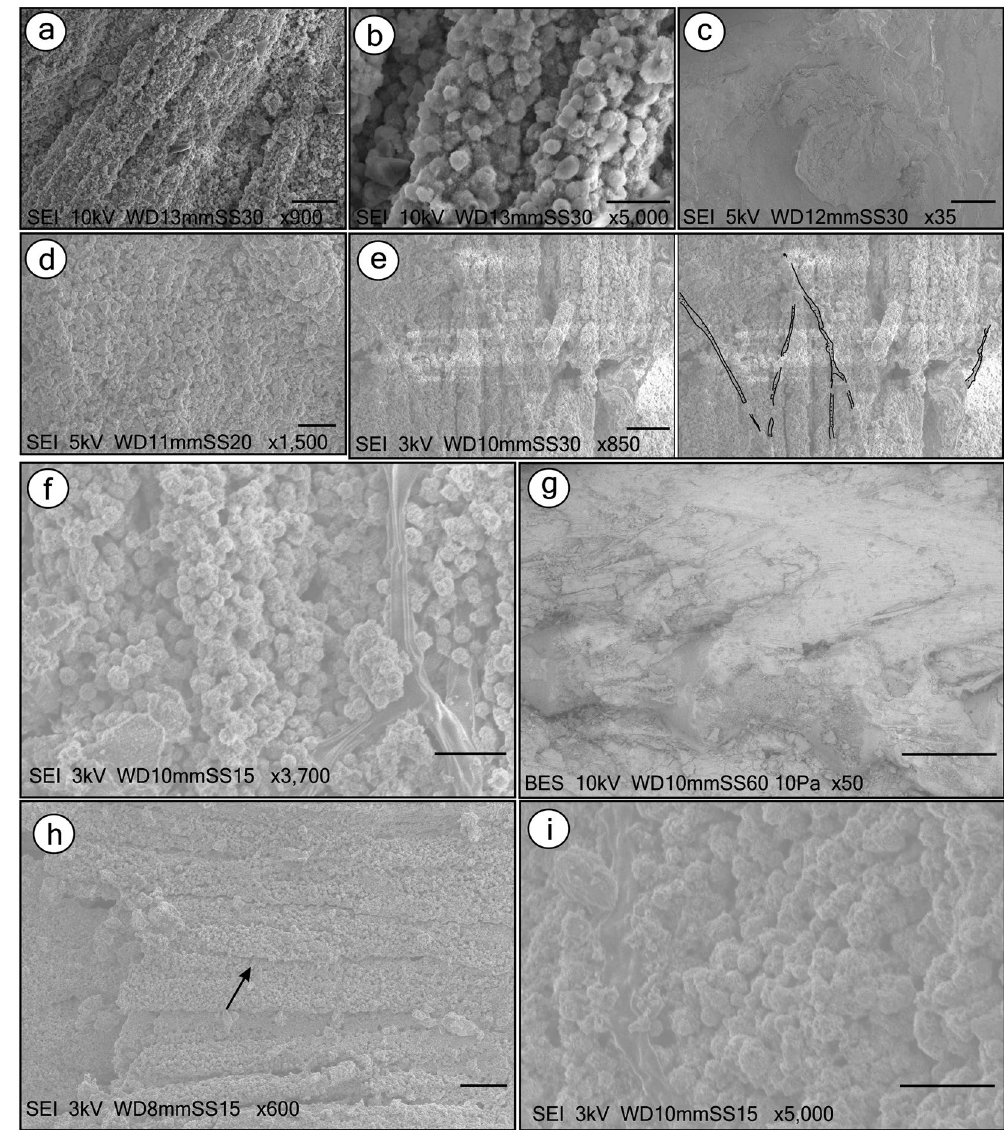
Figure 3. SEM of Crato Member BL fish soft-tissues, microfabrics and putative extracellular polymeric substances (EPS). The images of analyzed specimens and the localization of micrographs are depicted in Supplementary Figures 3, 4 and 6. ( a,b ) Micrographs of fish anteroposterior axis (below dorsal fin; Supplementary Figure 3) depicting fibre microfabric (Supplementary Figure 5). ( c ) depicts preserved eye (Supplementary Figure 6). ( d ) Shows eye microfabric. ( e ) (left) depicts fragmented and locally excavated muscle fibres subparallel to vertebral column. Gaps between fibres are occupied by wide, elongated, flat, soft-structures (sarcolemma), which also have orientations different from fibres. The same micrograph in the left is reproduced in the right with an interpretative drawing of the sarcolemma orientation. (f ) Detail of sarcolemma (right). ( g ) shows myomeres with muscle fibres (Supplementary Figure 4). ( h ) Possible nucleus (arrow). ( i ), Putative EPS covering grains (Supplementary Figure 7) in left half of the figure. Scale bars: ( a , e , h) – 20 µ m; ( b , f , i) – 5 µ m; ( c , g) – 500 µ m; ( d) – 10 µ